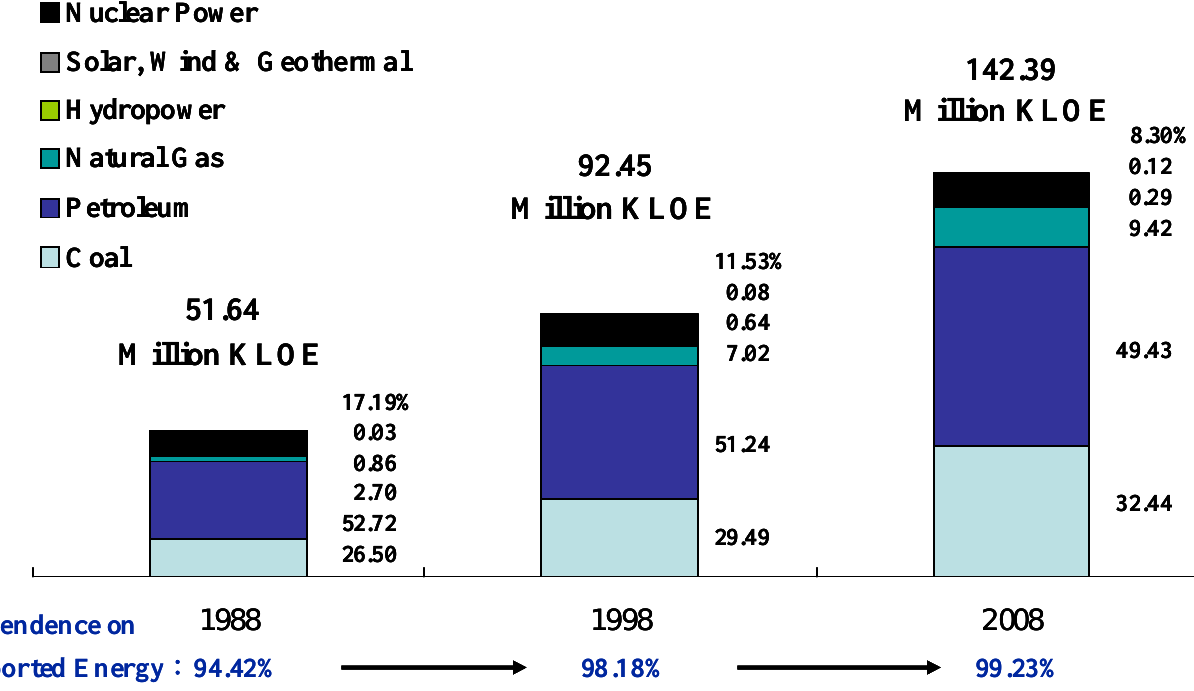
Imported Energy ：